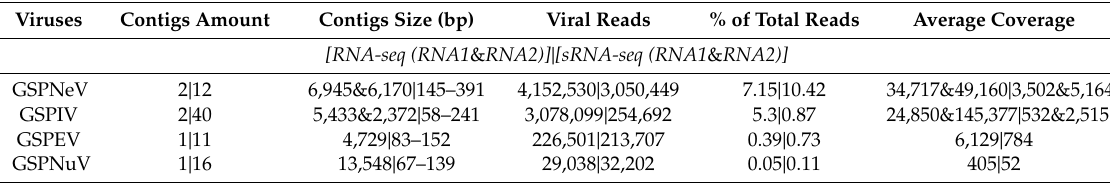
Table 1. Analysis of high-throughput sequencing data from the diseased tissues of green Sichuan pepper a ff ected by the flower yellowing